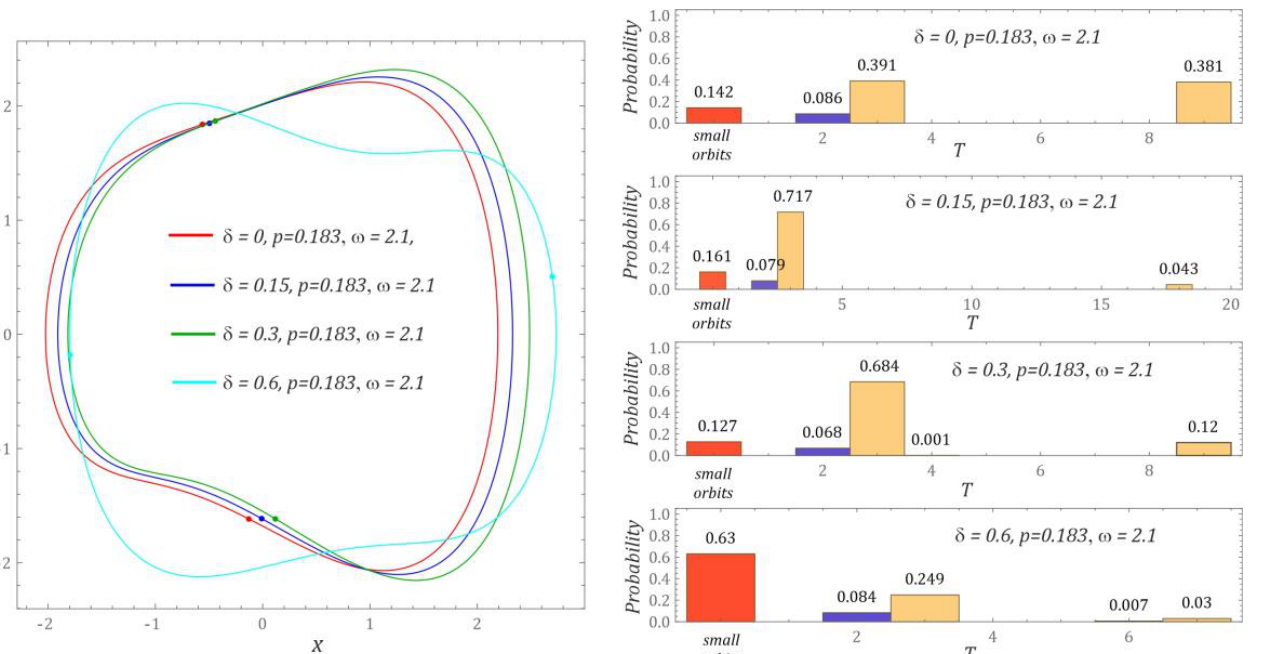
Figure 8. Numerical results showing the influence of potential asymmetry on the probability of oc- currence (periodic ity diagrams) of individual solutions for different values of ω (ω = 2 .6, 2.7, 2.8, 2.9, 3.0, 3.1, 3.4, 3.5, 3.6, 3.7, 3.8, and 3.9, respectively). The colors represent the different orbits of δ pa- rameter.